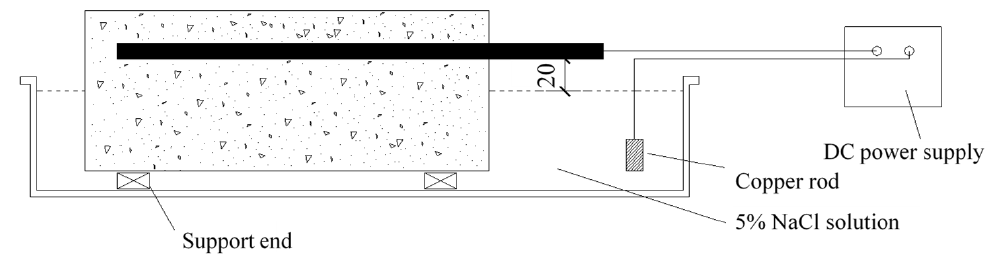
Figure 2. Accelerated corrosion test for the steel bar [33].